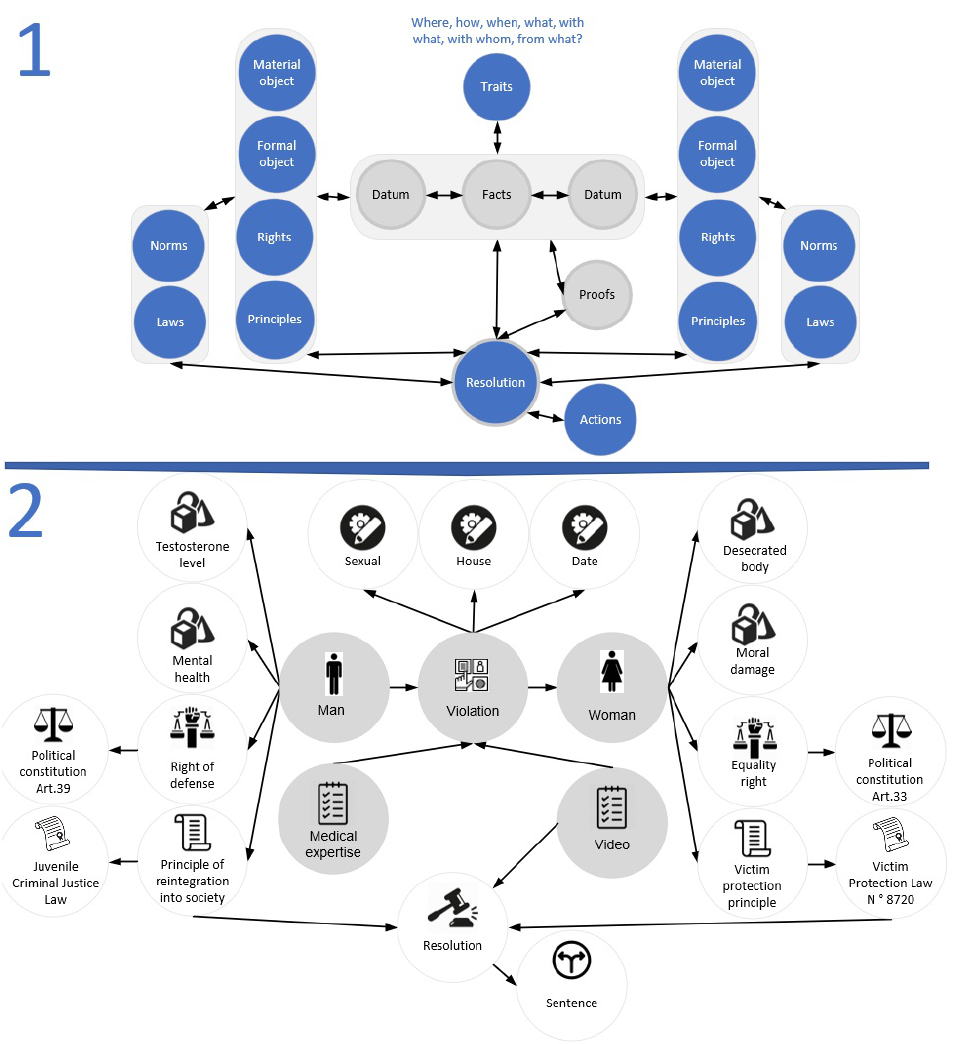
Figure 11. (1) Data model, and (2) property graph example, labels are omitted from relationships for